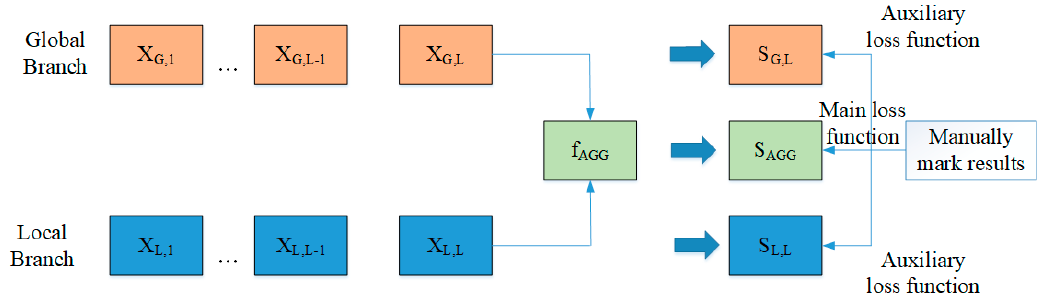
Figure 7. The process of aggregation.